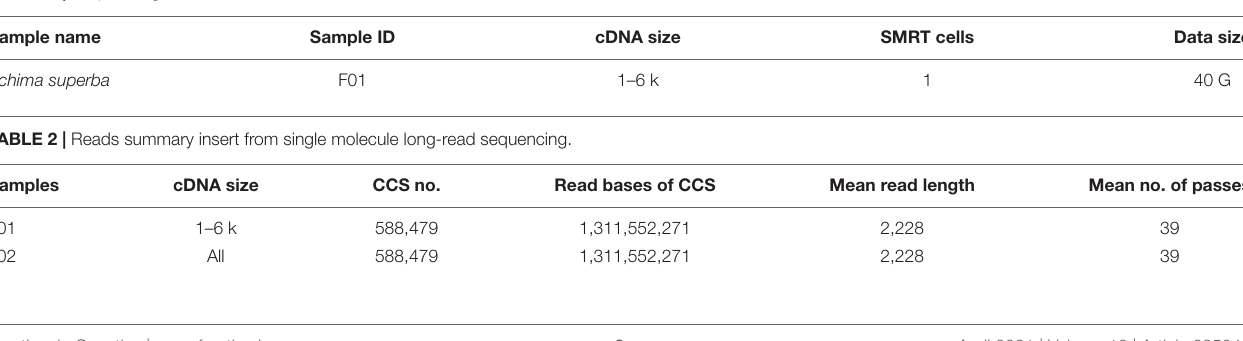
TABLE 1 | Sequencing data statistics table.